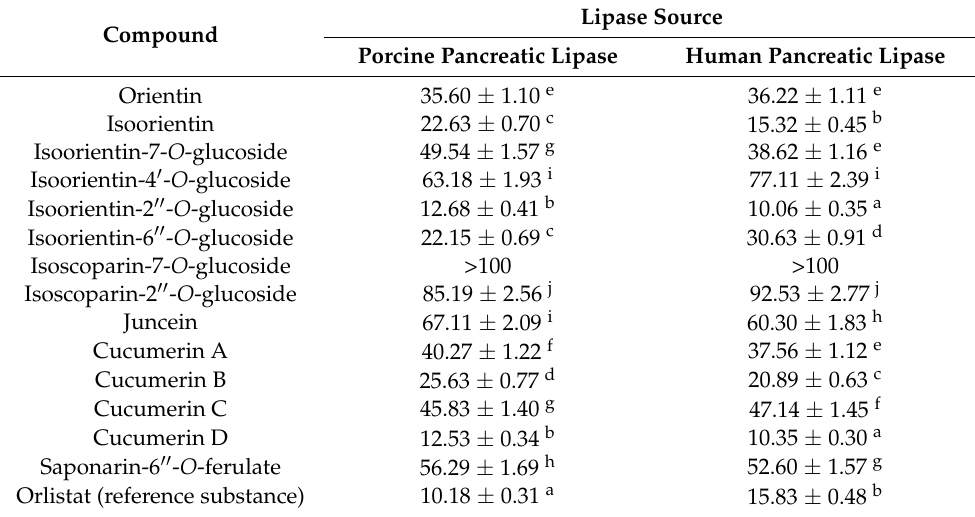
Table 8. Inhibition of mammal lipase activity by selected flavonoids from cucumber flowers, IC 50 , µ M ±